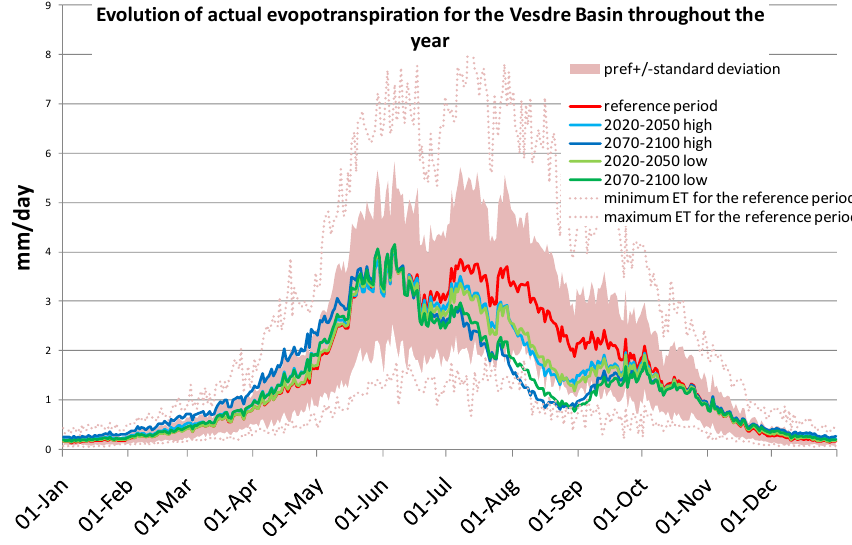
Fig. 8. Evolution of actual evapotranspiration for the Vesdre reference scenarios (red) and the four future scenarios. The shaded area represents the standard deviation for the reference period. Minimum and maximum represents the minimum and maximum values simulated during the reference